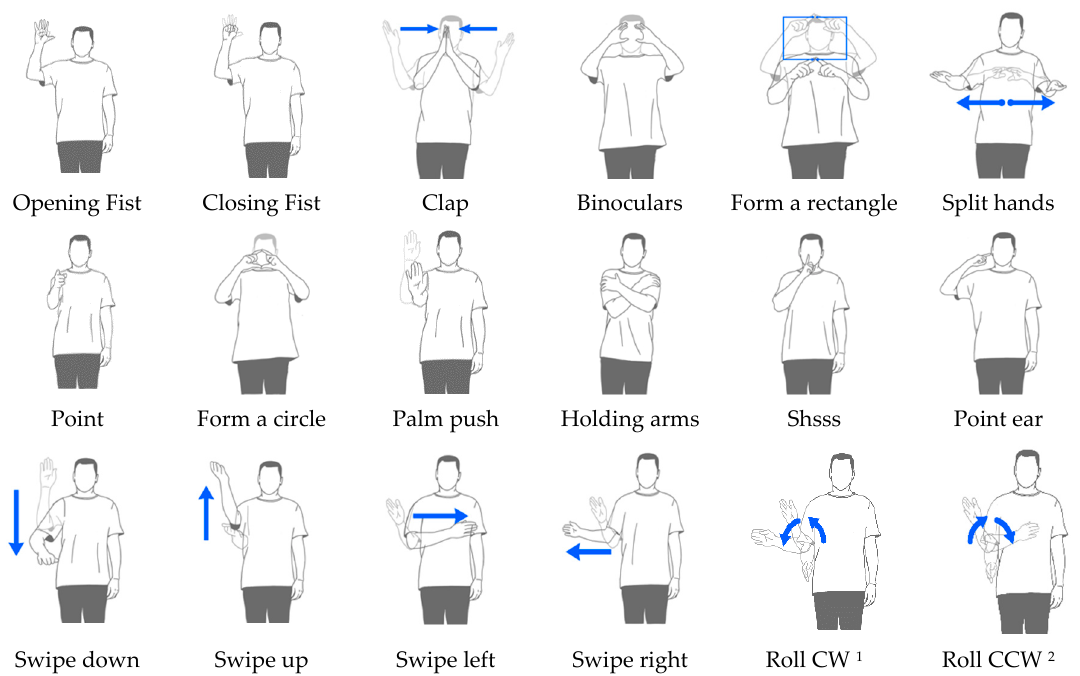
Figure 4. Gesture Set used in the prototype, as it was formed after the simplification refinement. 1 Clockwise, 2 Counterclockwise.